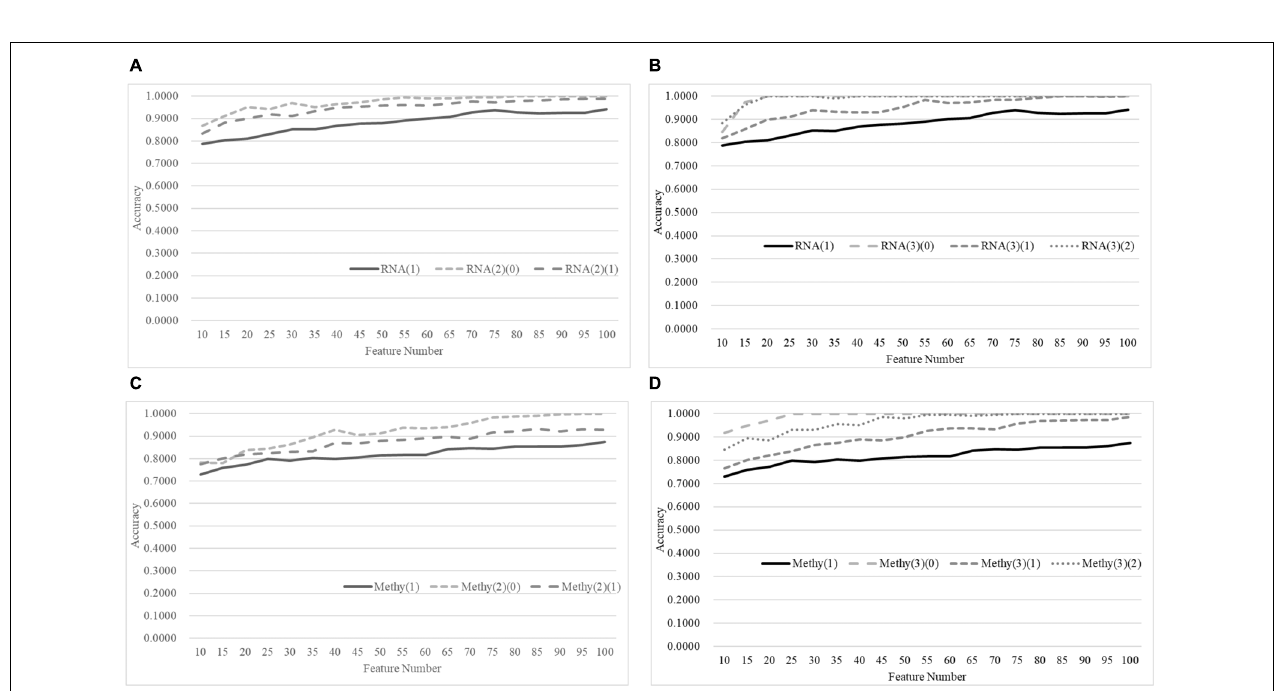
FIGURE 8 | Comparison of early-stage breast cancer detection models with different age groups based on both transcriptome and methylome data using the classifier SVM on the training datasets. Transcriptomes of the patients were split into (A) two groups and (B) three groups with equally-sized age ranges. The methylomes were split into (C) two groups and (D) three groups in the same way. The horizontal axis shows the numbers of features chosen by rfeSVM and the vertical axis shows the 10-fold cross-validation accuracy of the classifier SVM. F -test was used to generate the initial subset of 1000 top-ranked features.